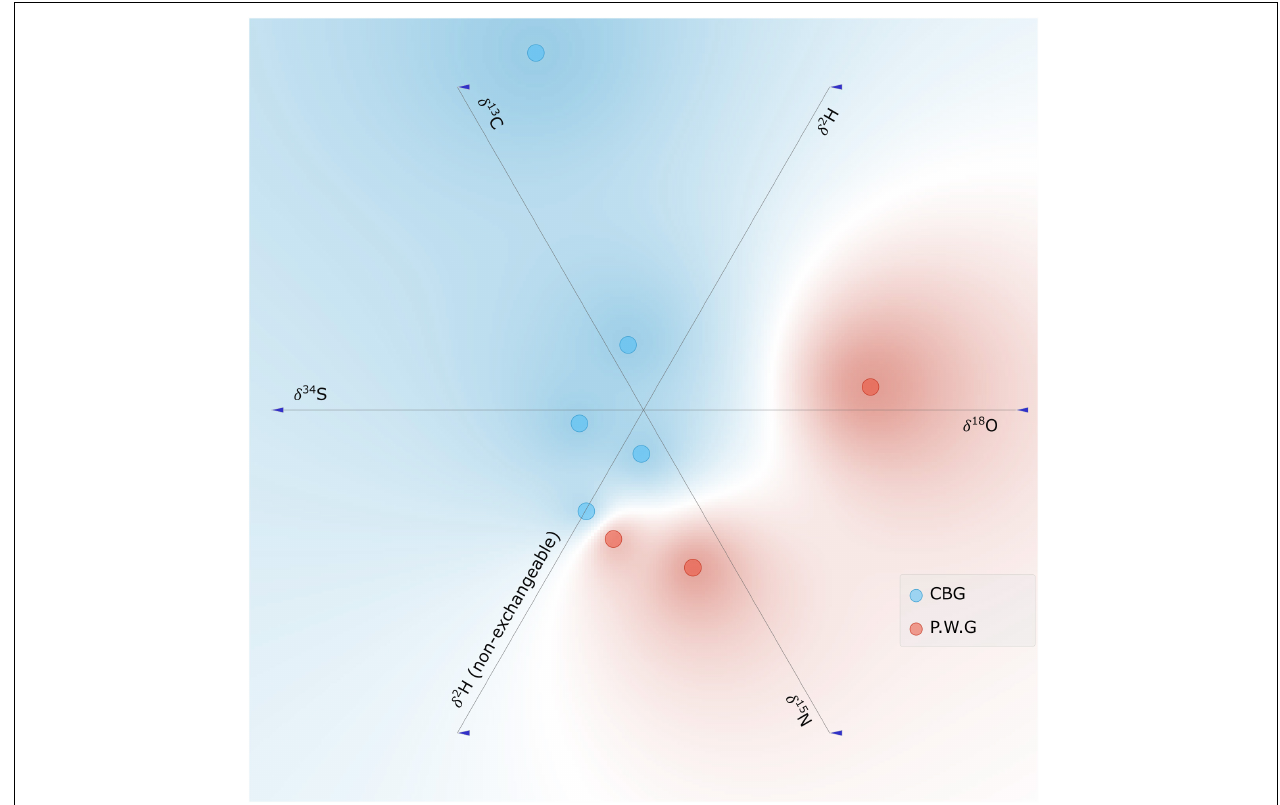
FIGURE 6 | Linear projection of Dacryodes buettneri stable isotope